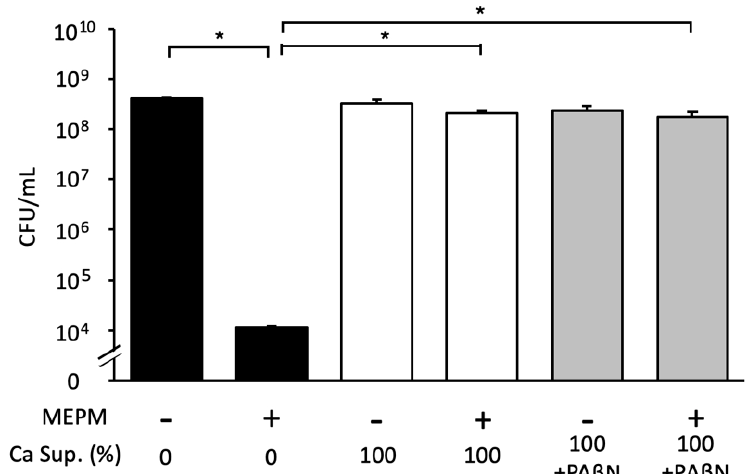
Figure 6. Effect of Candida culture supernatant (Ca Sup.) treated with drug efflux pump inhibitors on E . coli biofilm formation in the presence of MEPM. The drug efflux pump inhibitor PA β N was added to the supernatant. Measurements were performed three times, and the data are presented as the mean ± standard deviation. n = 3/group. Statistically significant differences between groups were evaluated using Tukey’s test with one ‐ way ANOVA; * p < 0.05.